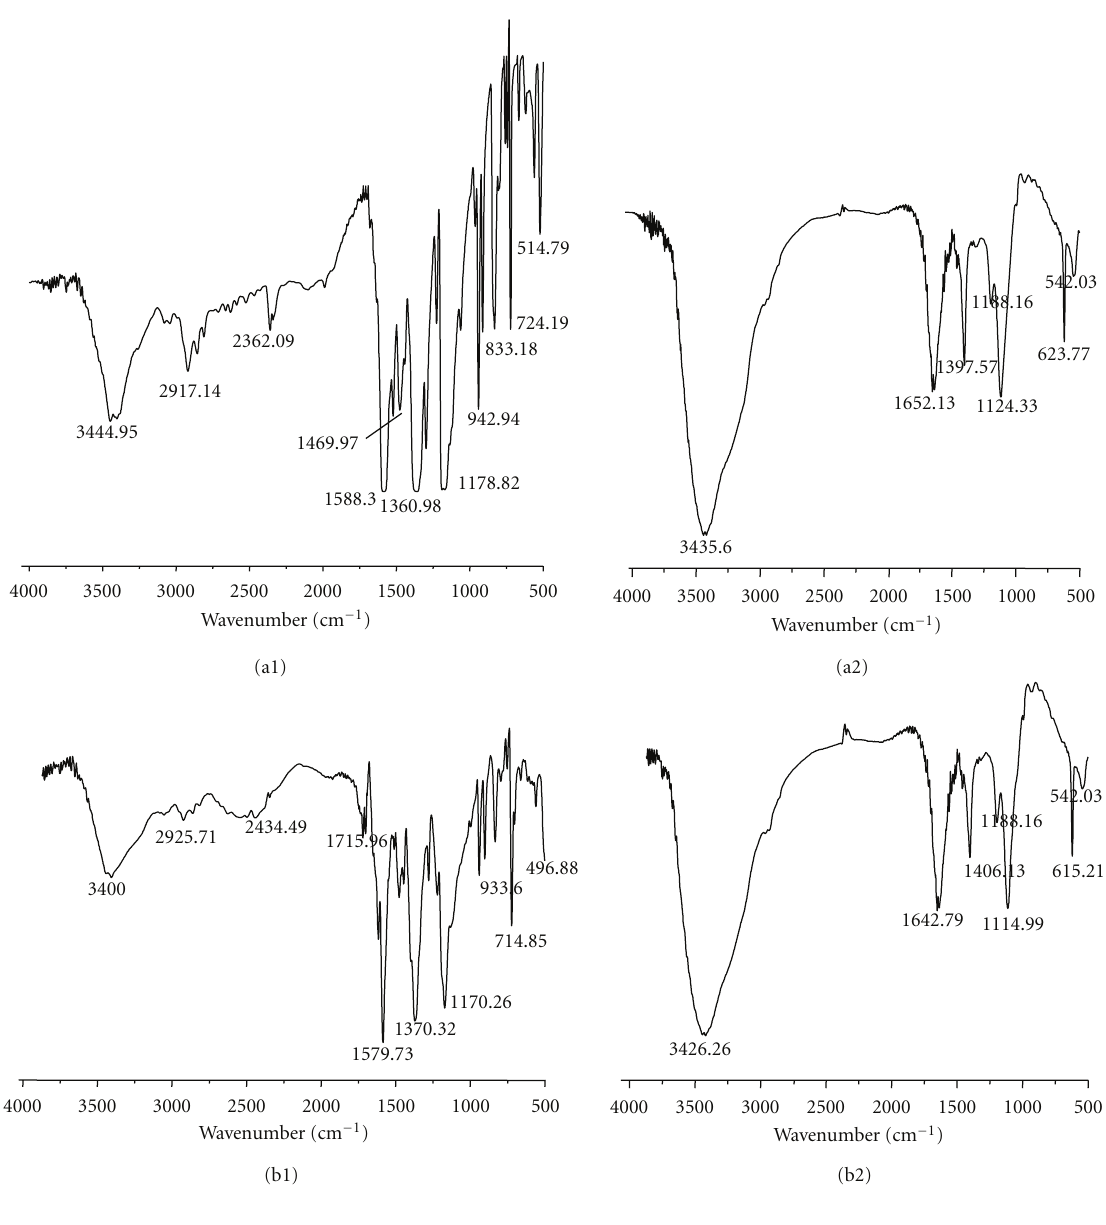
Figure 4: FT-IR spectra of crystal violet and malachite green (a1) and (b1) at 0 h (control), respectively. The spectra (a2) and (b2), for CV and MG were obtained after 2h of degradation by a consortium CM-4, the experiment was realized at the same conditions.